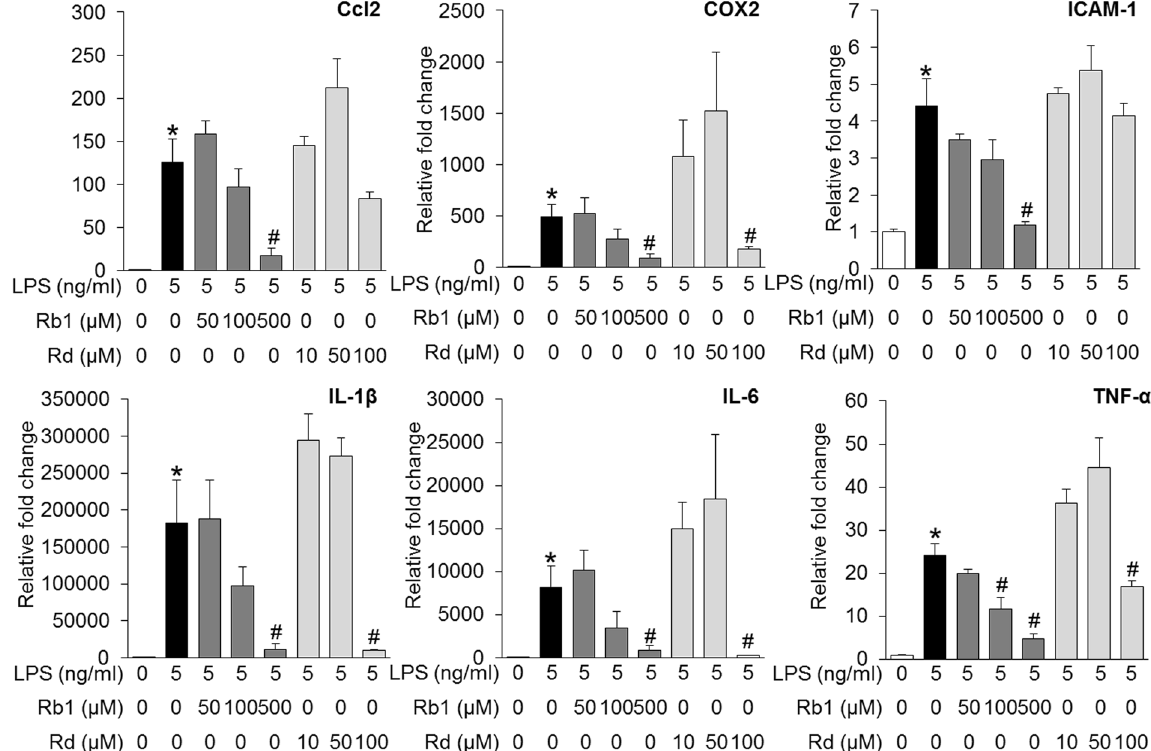
Figure 9. Rb1 or Rd treatment suppressed LPS-stimulated expression of proinflammatory genes in RAW264.7 cells. Rb1 and Rd were added to RAW264.7 cells at the indicated concentrations 30 min before LPS stimulation delivered at 5 ng/ml for 6 h. Cells were harvested for total RNA extraction and real-time PCR analyses to assess the expression of Ccl2, COX2, ICAM, IL-1 β , IL-6 and TNF- α (n = 4 per group). The data were expressed as the mean ± S.E.M. * Compared to that from vehicle-treated cells without LPS incubation, p < 0.05; # compared to that from vehicle-treated cell with LPS stimulation, p <